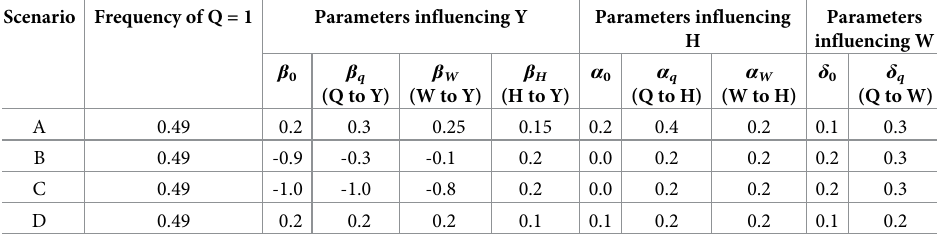
Table 3. The parameter values for each scenario used to simulate discrete binary data. Models are described in detail by Shih et. al.